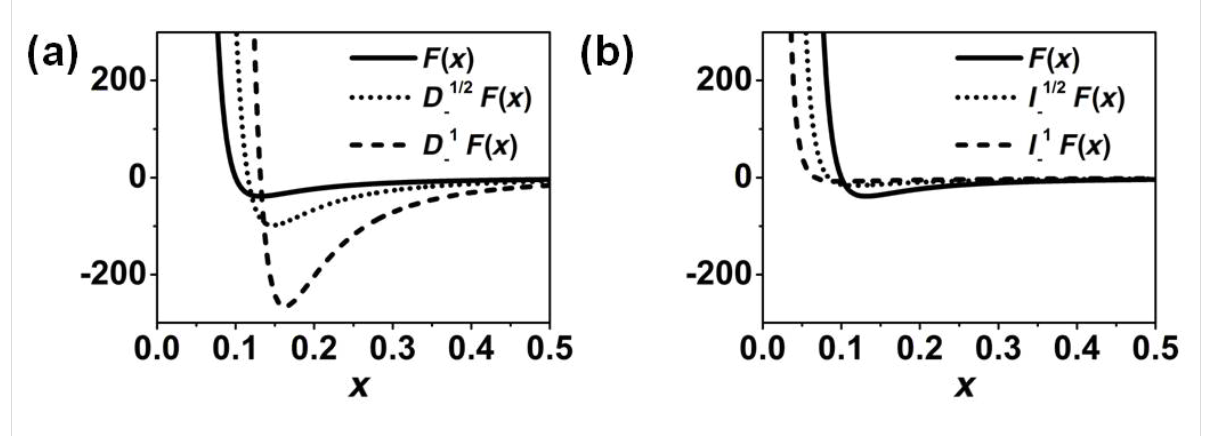
Figure 2: Fractional operators of (0.1 4 / x 6 − 1/ x 2 ). (a) The function, half-derivative and derivative are plotted. (b) The function, half-integral and inte- gral are plotted.